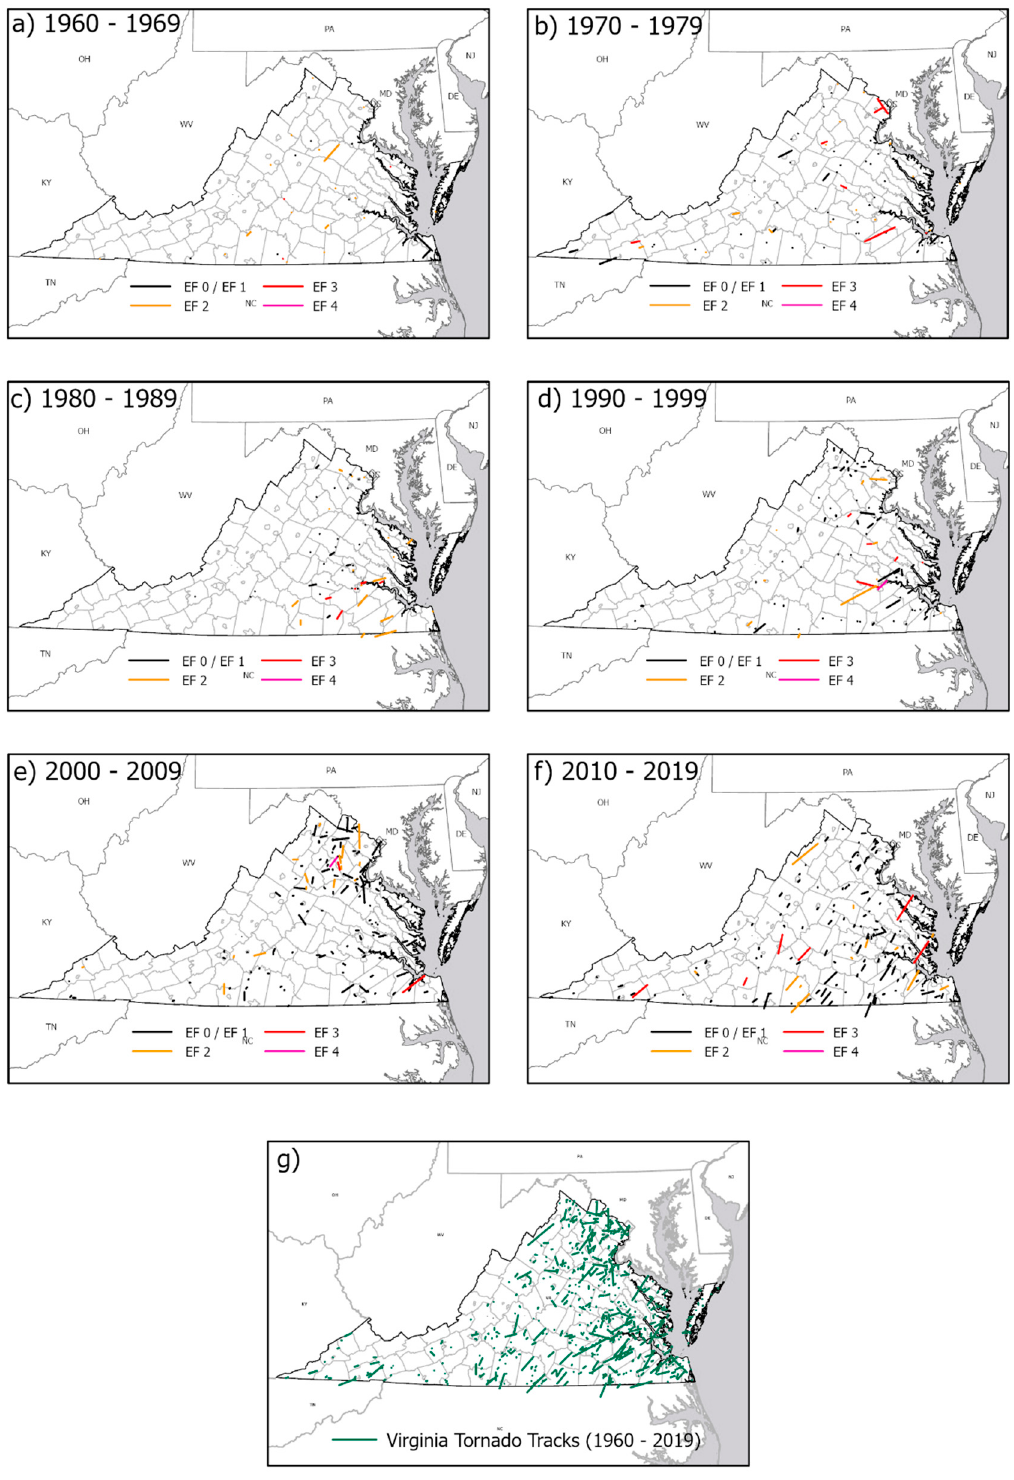
Figure 2. Tornado track time series by decade and EF scale starting in 1950 and ending in 2018. all Virginia